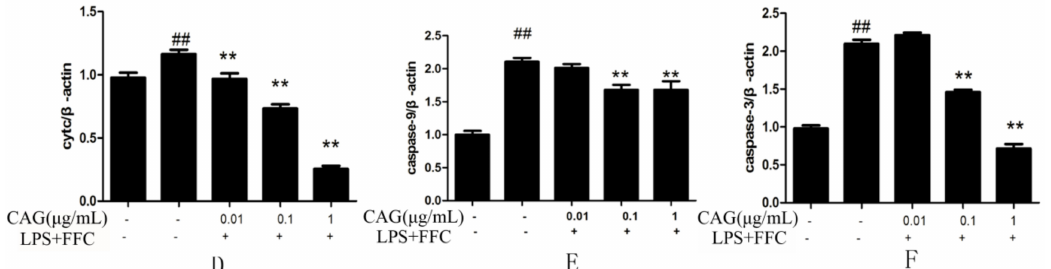
Figure 5. Effect of CAG on LPS/AC-induced changes in the expression of apoptosis-related proteins in hepatocytes. ( A ) western blot bands; ( B ) bcl-2; ( C ) bax; ( D ) cytc; ( E ) caspase-9; ( F )caspase-3. β -actin is used as reference. The data are expressed as the mean ± SD (n = 3). # p < 0.05, ## p < 0.01 compared to the control; * p < 0.05, ** p < 0.01 compared to the model group.